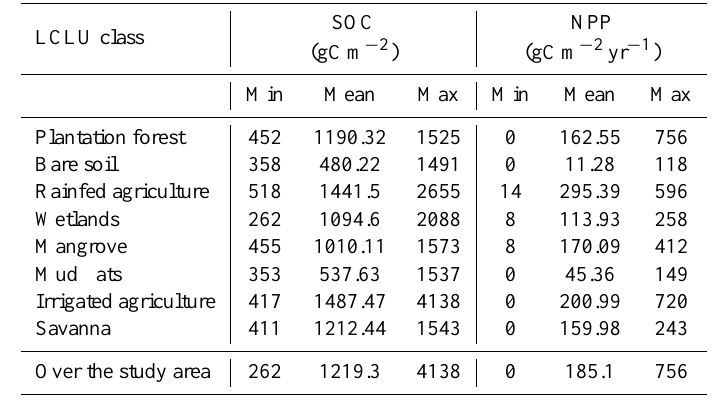
Table 4. Comparison of the minimum, mean and maximum SOC (Fig. 3) and NPP (Fig. 4) simulated for the 9 LCLU classes using the year 2000 hard classification (Fig. 1). Only pixels where SOC and NPP was modeled are considered (i.e., not water bodies, clouds, cloud shadows, settlement areas, or where there was no Landsat data).